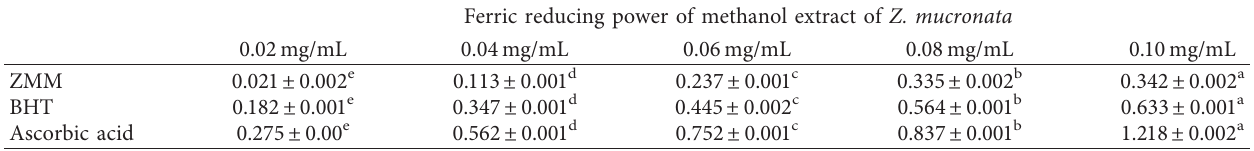
Table 1: Mean ± SD of ferric reducing power of methanol extract of Z. mucronata . Ferric reducing power of methanol extract of Z. mucronata